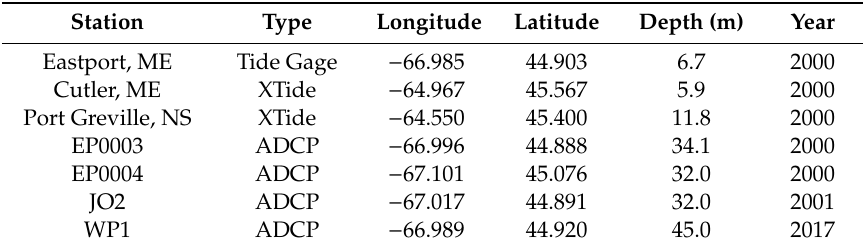
Table 1. List of observed data stations for model calibration and validation.